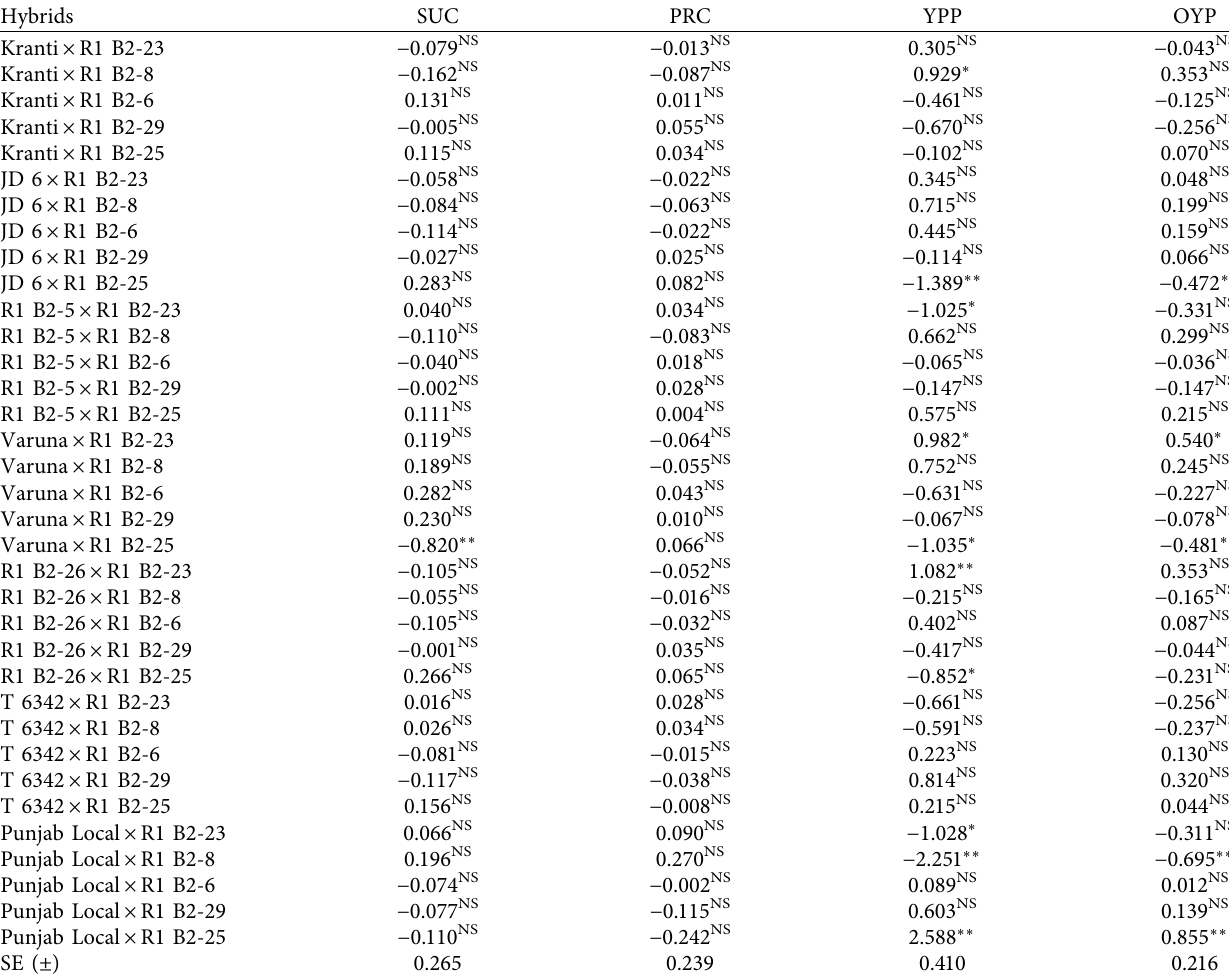
Table 12: Specific combining ability (SCA) effects of mustard hybrids on yield and its attributed traits.